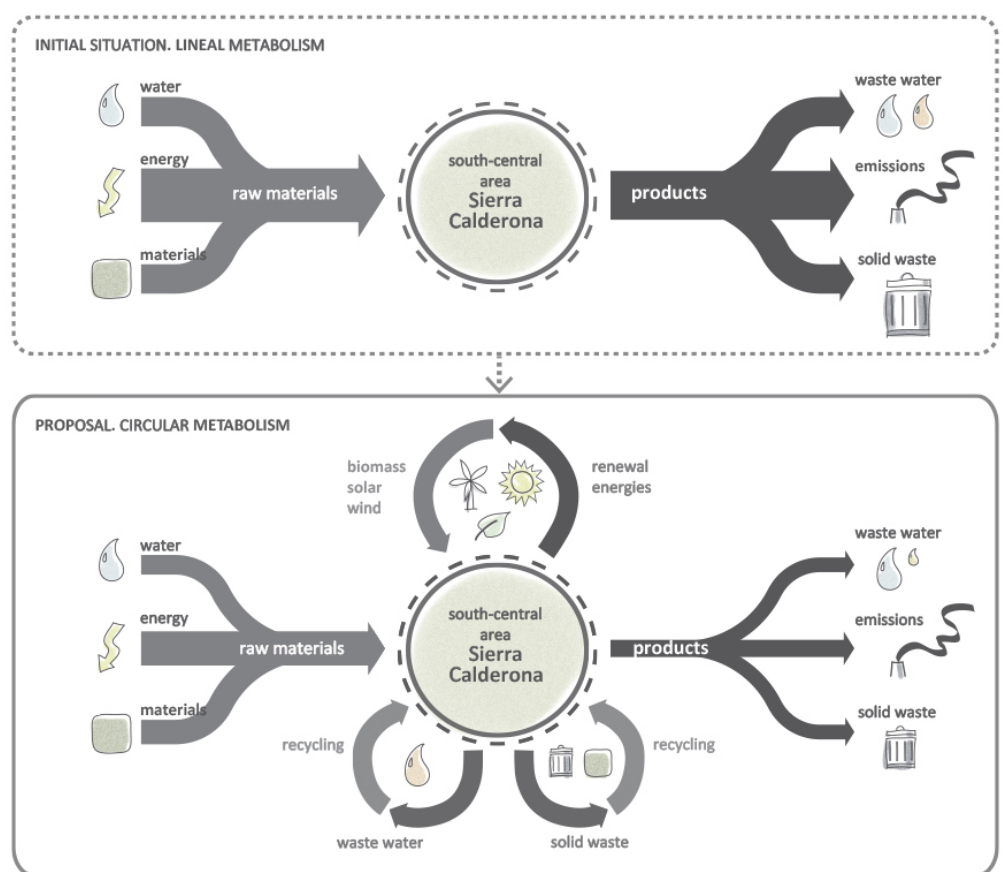
Figure 7. Overview of first-level regional “mainstream” strategies to favour transition towards a circular metabolism in the Sierra Calderona. Source: Galan (2014b) adapted from Rogers